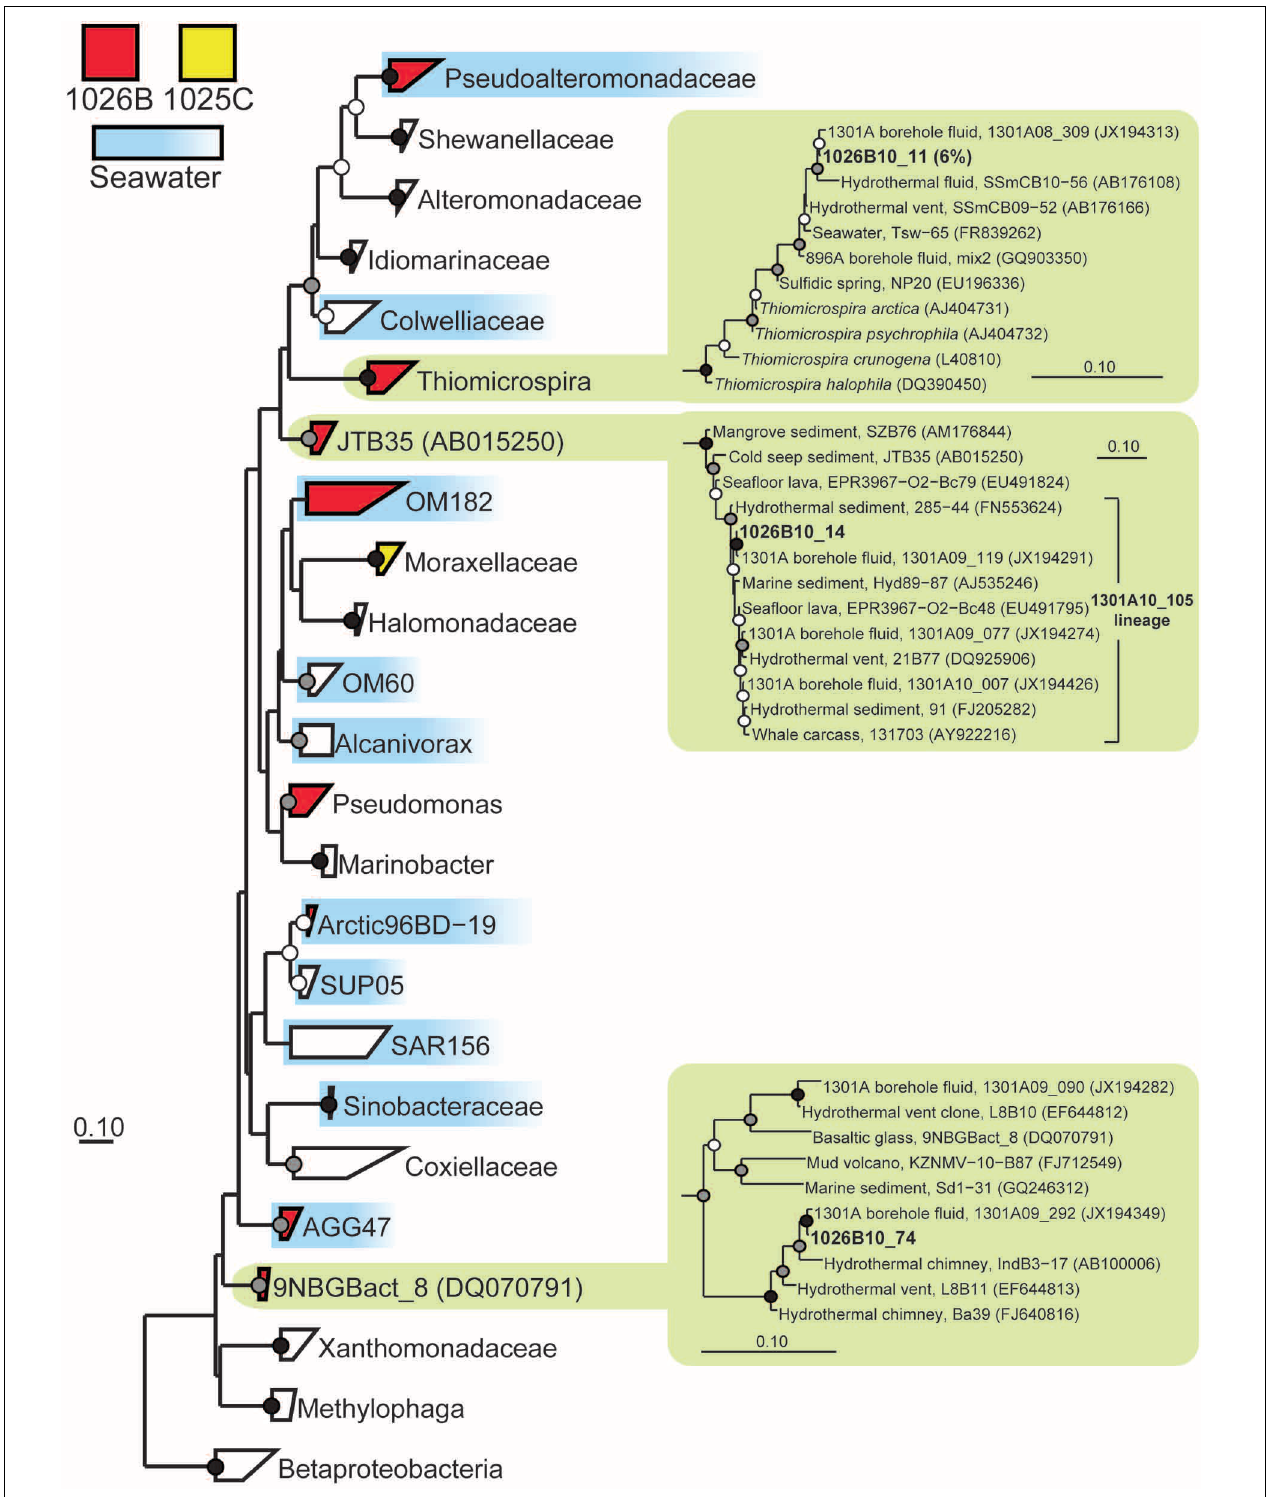
FIGURE 5 | Phylogenetic relationships of SSU rRNA gene clones related to the phylum Gammaproteobacteria , colored as in Figure 3. A variety of Betaproteobacteria were used as outgroups (not shown). Detailed phylogenies are shown for selected lineages. Other information as in Figure 3 .